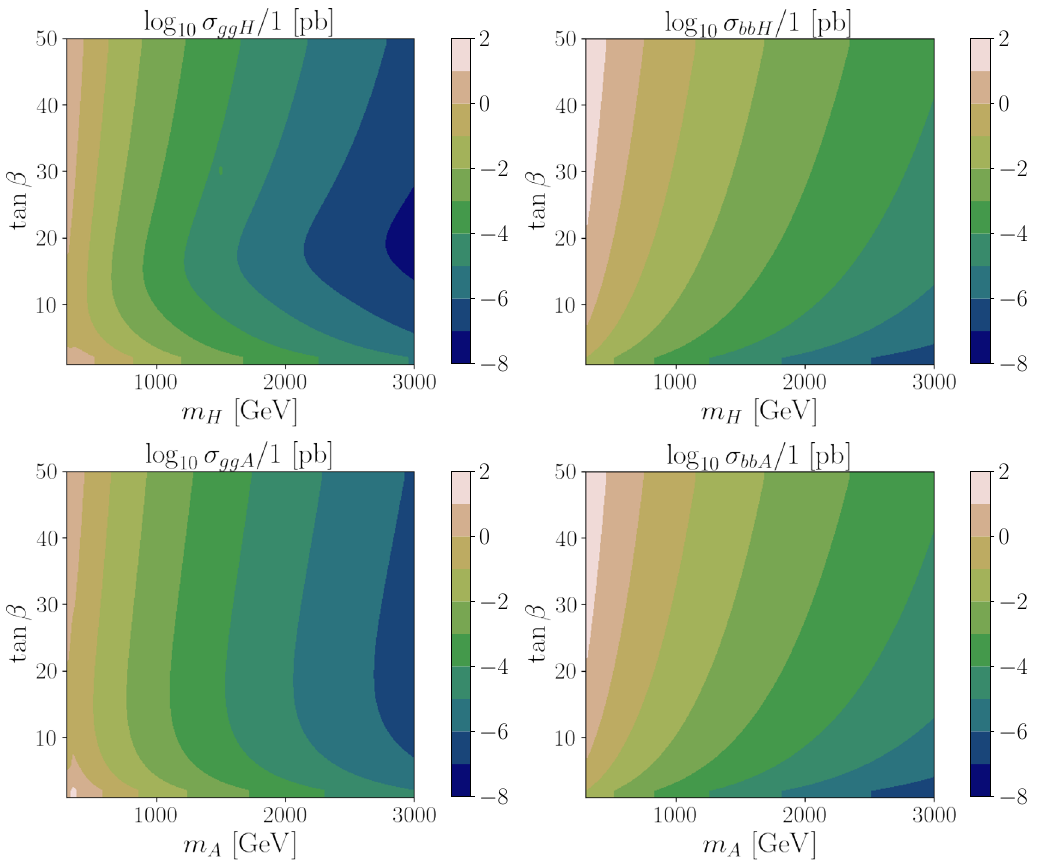
Figure 7 . Production cross sections of the neutral Higgs bosons H (upper) and A (lower) via the ggF (left) and bbH (right) processes at